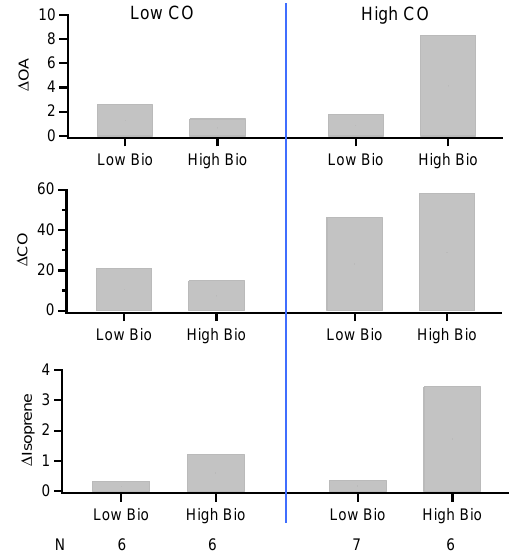
Figure 10. Bar graphs for subsets defined on the basis of (cid:49) CO and (cid:49) CH 3 OH. Same format as Fig.